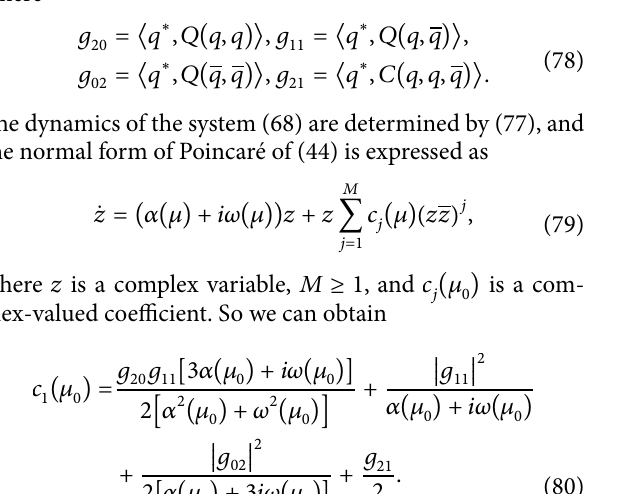
∗ ∗ ( 𝑎 , 𝑠 ) = (1.500, 0.4444) (𝑥, 𝑡)